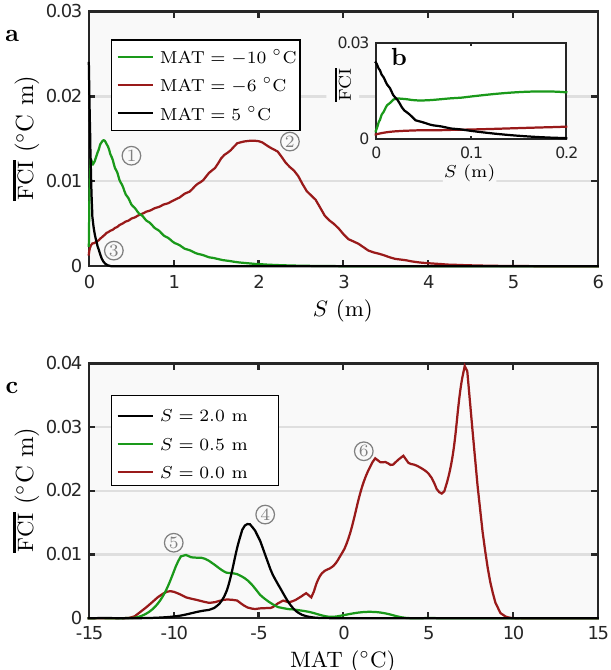
Figure 6. The integrated frost-cracking intensity along profiles shown in Fig. 5. Panel (a) : profiles along the S axis illustrate how FCI depends on sediment thickness for three different MATs. Note the exponential decay function for MAT = 5 ◦ C and the humped function for the two colder settings. Panel (b) : inset highlighting the change in FCI for thin sediment cover. Panel (c) : profiles of FCI parallel to the MAT axis showing how the effects of climate depend on sediment thickness. Areas with no or very little sediment cover (red line) have the highest FCI in warm regions, where rapid freez- ing events in winter promote intense cracking. In regions with per- mafrost (MAT < 0 ◦ C), frost cracking is most intense under thicker